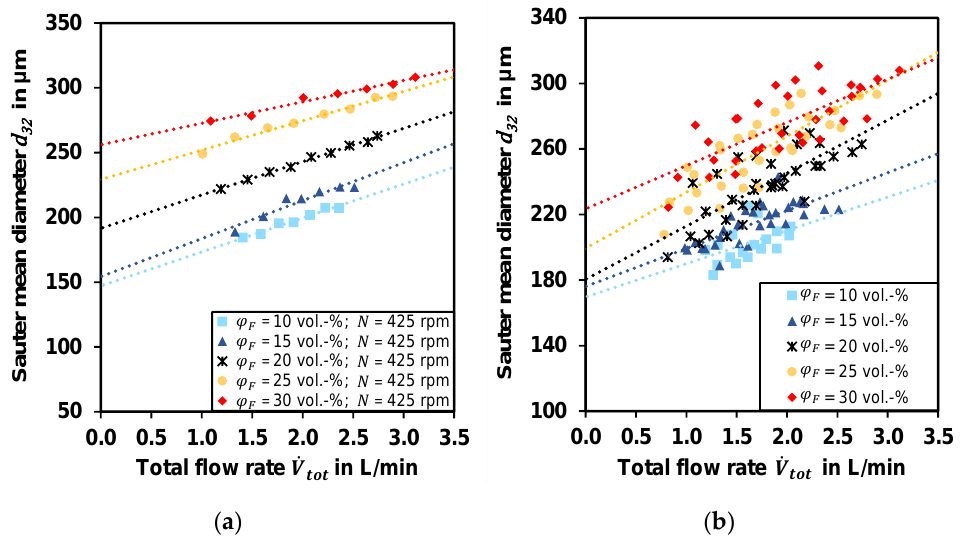
Figure 9. ( a ) Measured Sauter mean diameters for 𝑁 = 425 rpm at measurement position 𝑀𝑃 1 at different feed phase ratios 𝜑 𝐹 and total flow rates 𝑉̇ 𝑡𝑜𝑡 . The dashed lines are linear least square lines as a guide for the eye. ( b ) Measured Sauter mean diameters at all impeller speeds 𝑁 = 375, 400, and 425 rpm at different feed phase ratios and flow rates. The dashed lines are linear fits as a guide for the eyes. All Sauter mean diameters are measured at measurement position 𝑀𝑃 1 .